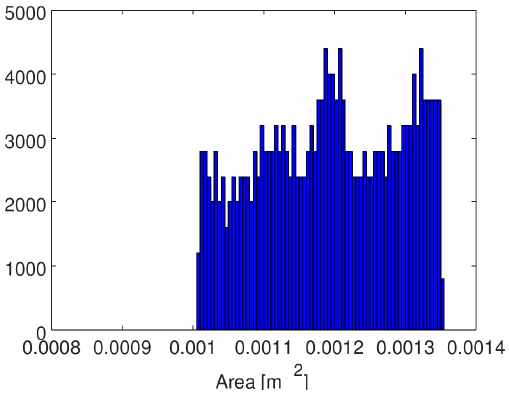
Figure 15. Pdf of cross-section area with uniform input distribution of vf .